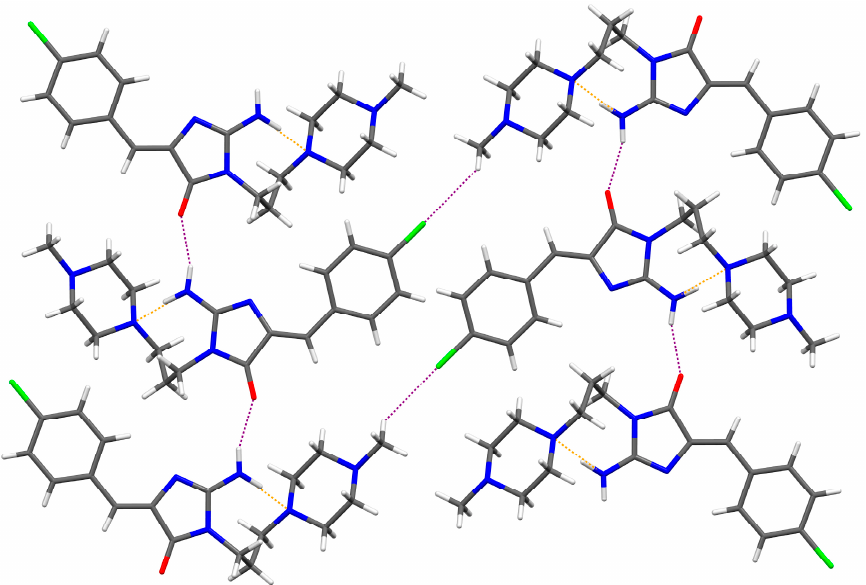
Figure 4. Partial packing view of compound 7 along [100] direction. Dashed lines indicate hydrogen bonds: orange - intramolecular, purple - intermolecular.